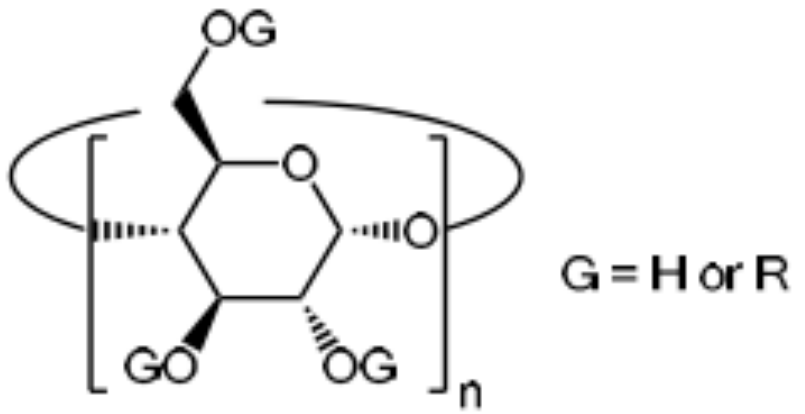
Figure 6. Chemical structure of cyclodextrins [148].